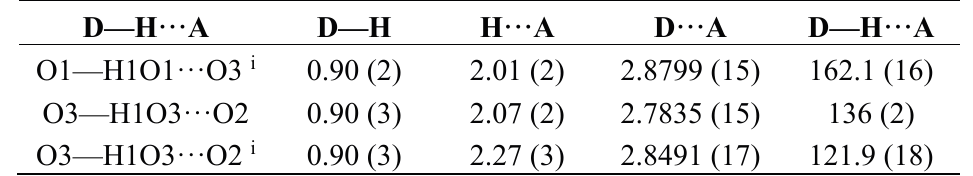
Table 2. Hydrogen-bond geometry (Å, °) of 1